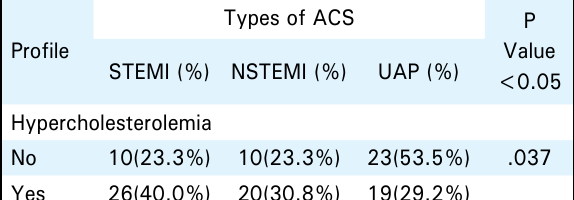
table 6. Correlation of clinical profile with types of Acs (n